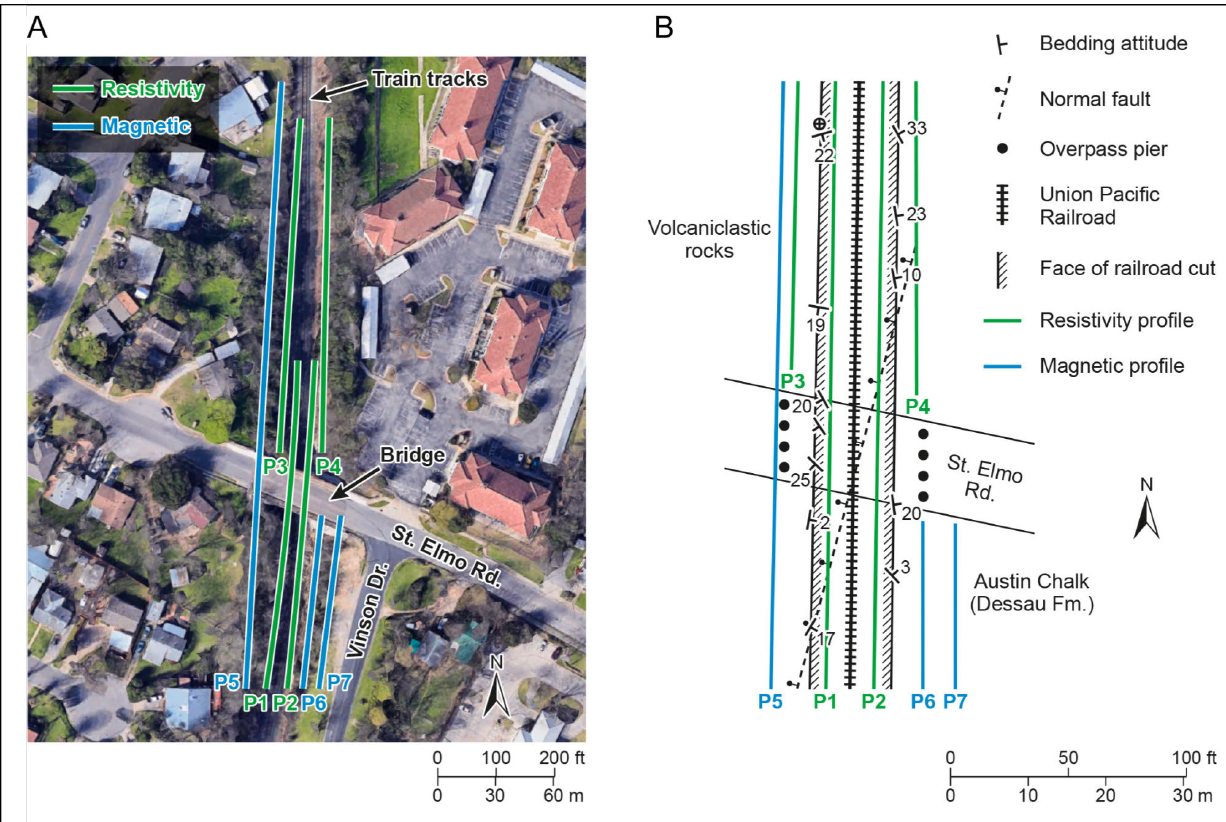
Figure 6: Locations of geophysical profiles on a site map [A] and on a schematic geological map of the St. Elmo site [B]. The geological map was published in Caran et al. [2012]. Note that all profiles (except P6 and P7) extend in the southern and northern directions beyond the map